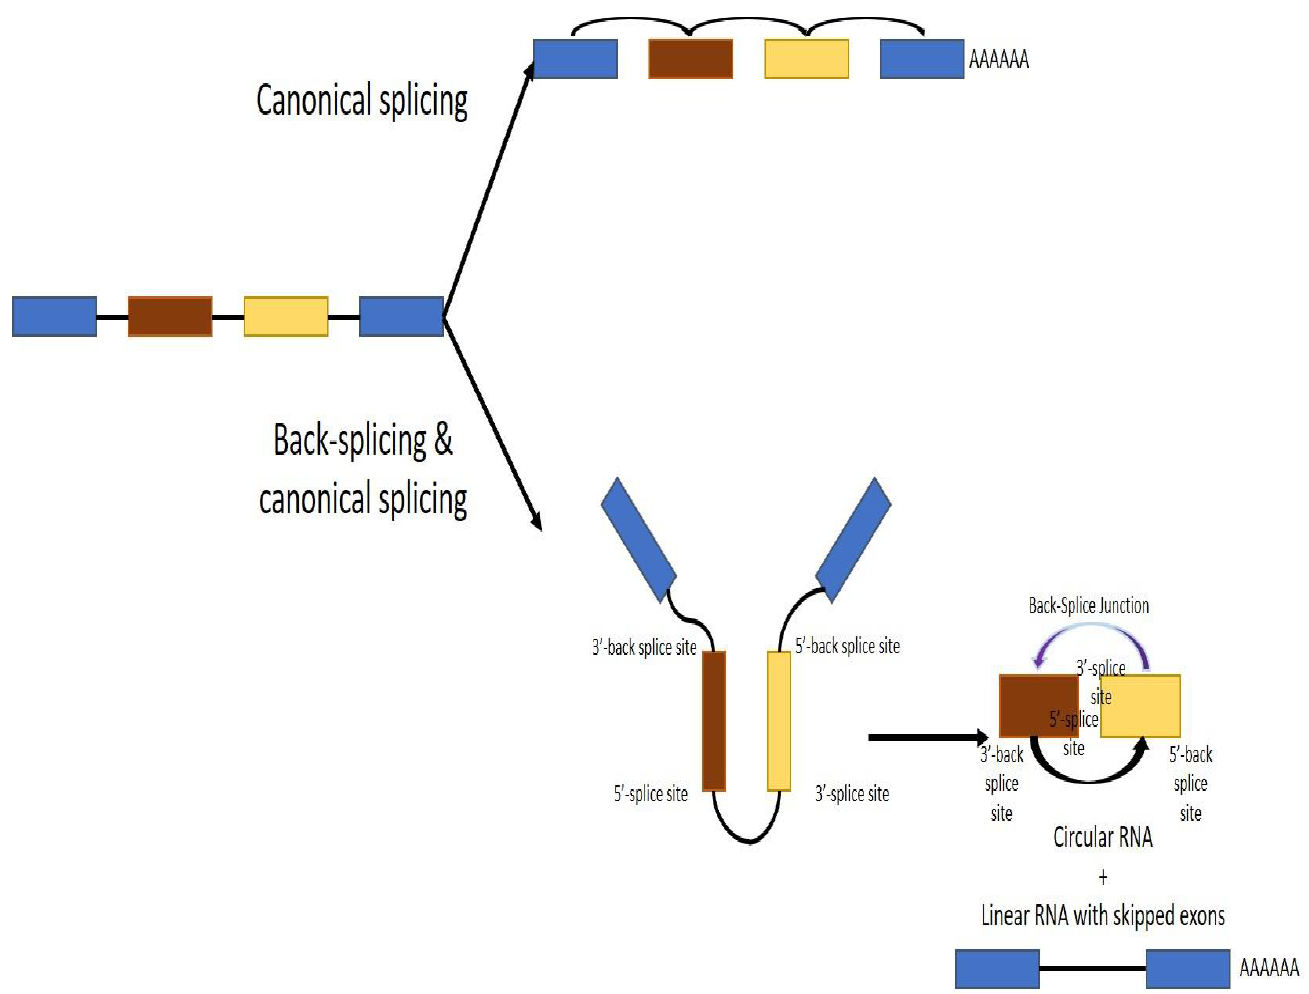
Figure 1. Biogenesis of circular RNAs.